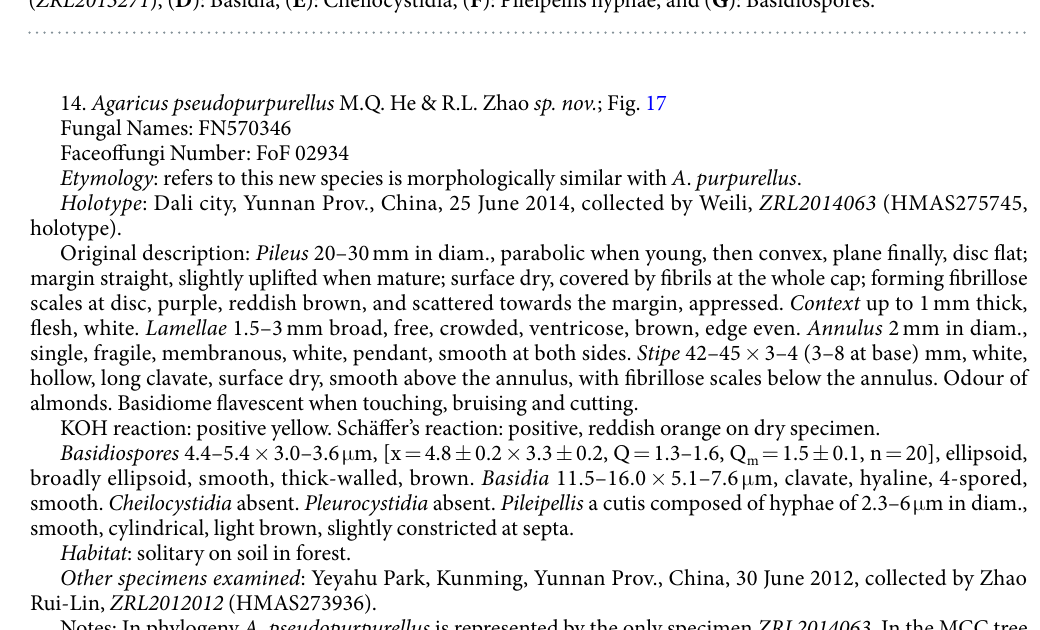
Figure 16. Morphology of Agaricus elongatestipes ( ZRL2013271 , holotype), ( A – C ): Basidiome in field ( ZRL2013271 ), ( D ): Basidia, ( E ): Cheilocystidia, ( F ): Pileipellis hyphae, and ( G ):